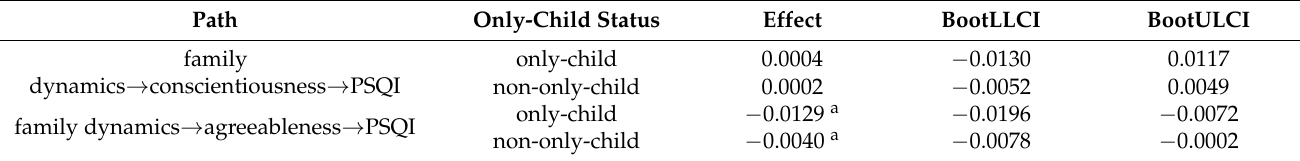
Table 6. Bootstrapping the conditional indirect effect and 95% confidence interval (CI) for the moderated mediation